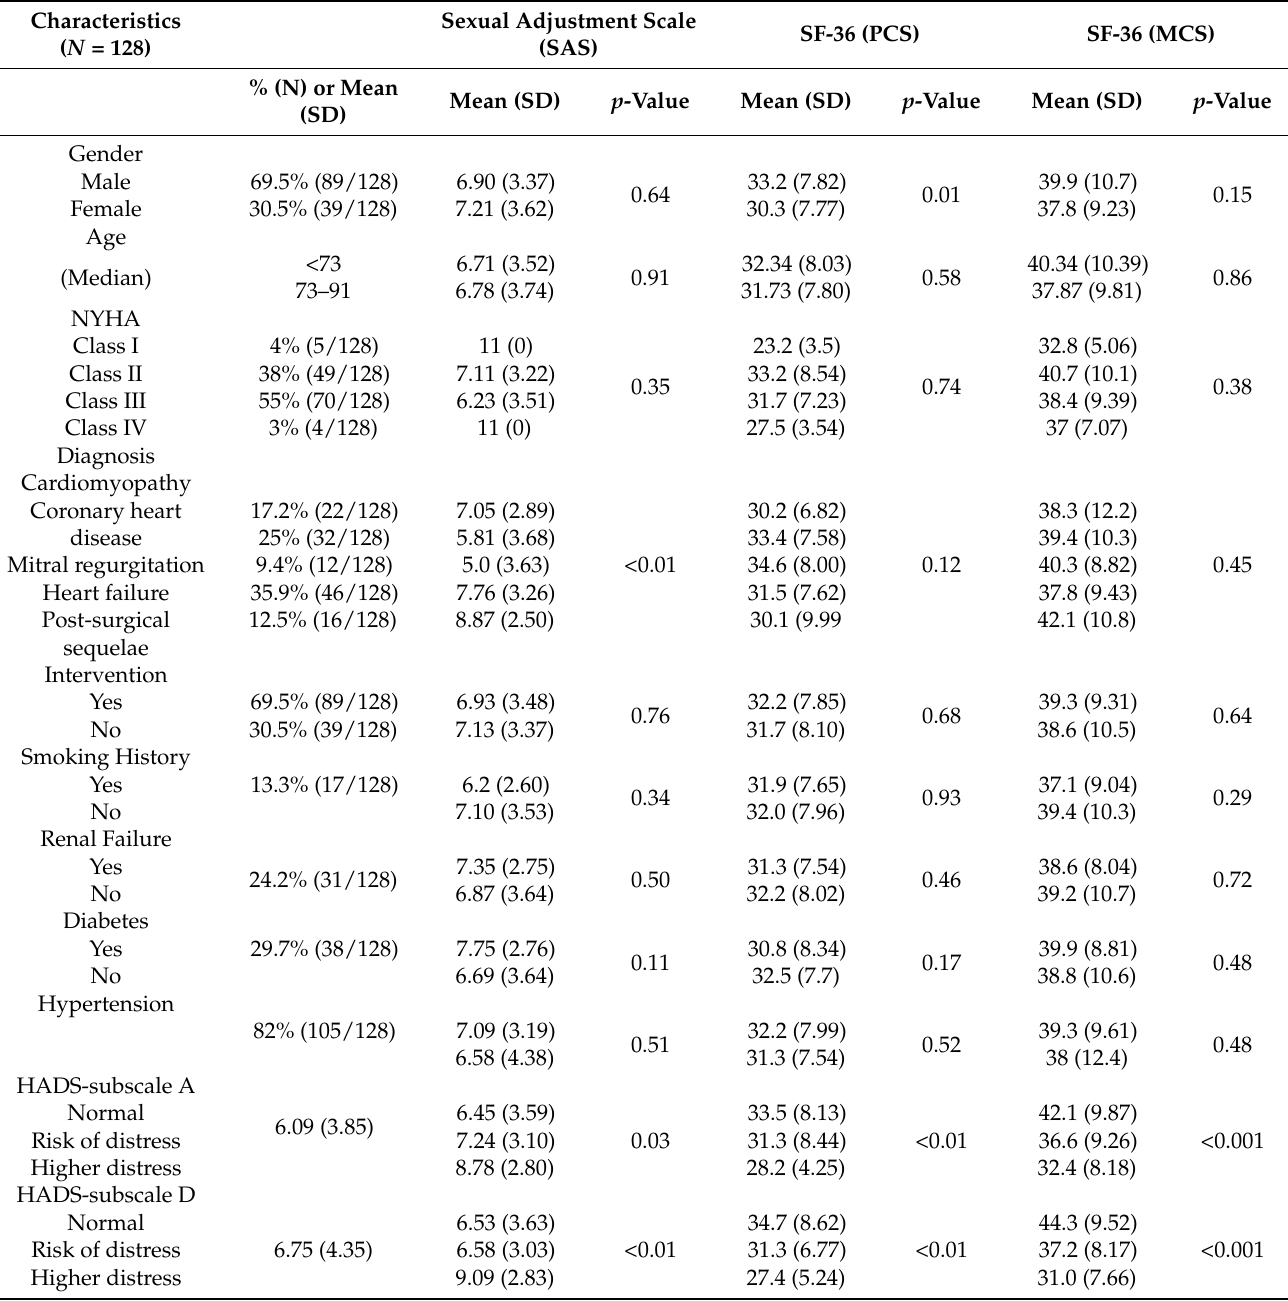
Table 1. Characteristics of study